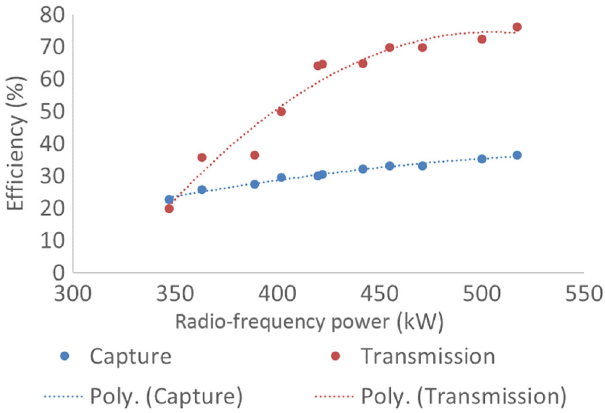
FIG. 19. Capture and transmission efficiencies versus linac rf